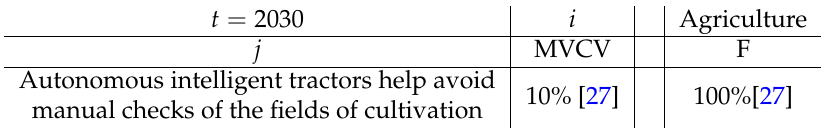
Table 8. Smart Agriculture saving ICT